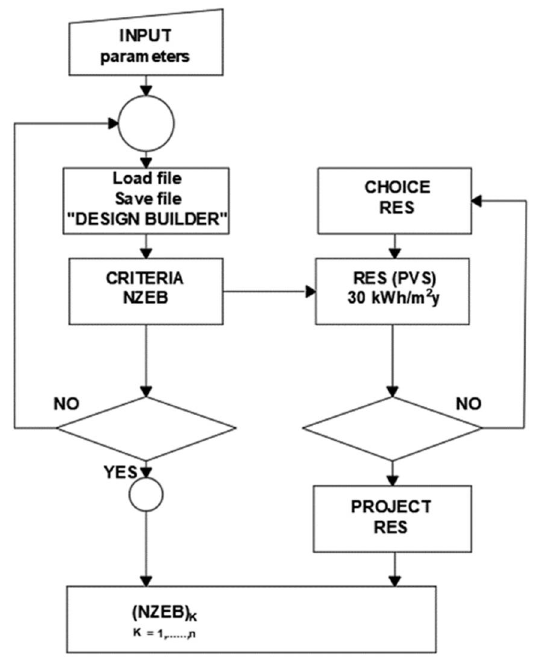
Figure 1. Energy model of a building: existing (current).